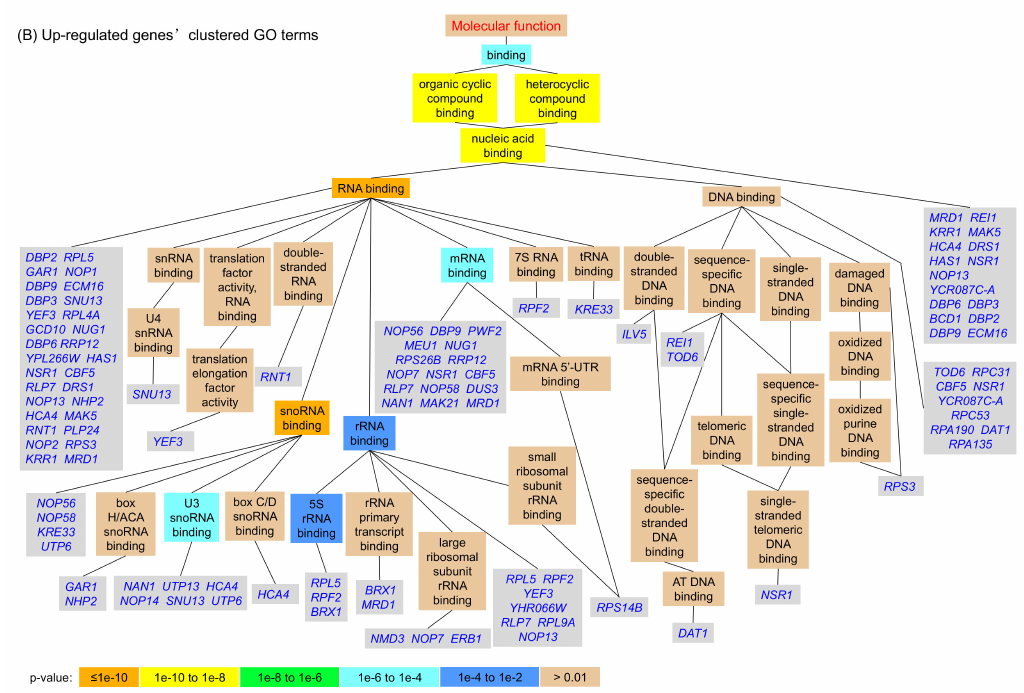
Figure 3. Clustered GO (gene ontology) terms for genes that show significant di ff erential expression in the yeast strain expressing HXK2 S14A compared to its parent strain. ( A ) Down-regulated genes’ clustered GO terms; ( B ) Up-regulated genes’ clustered GO terms.